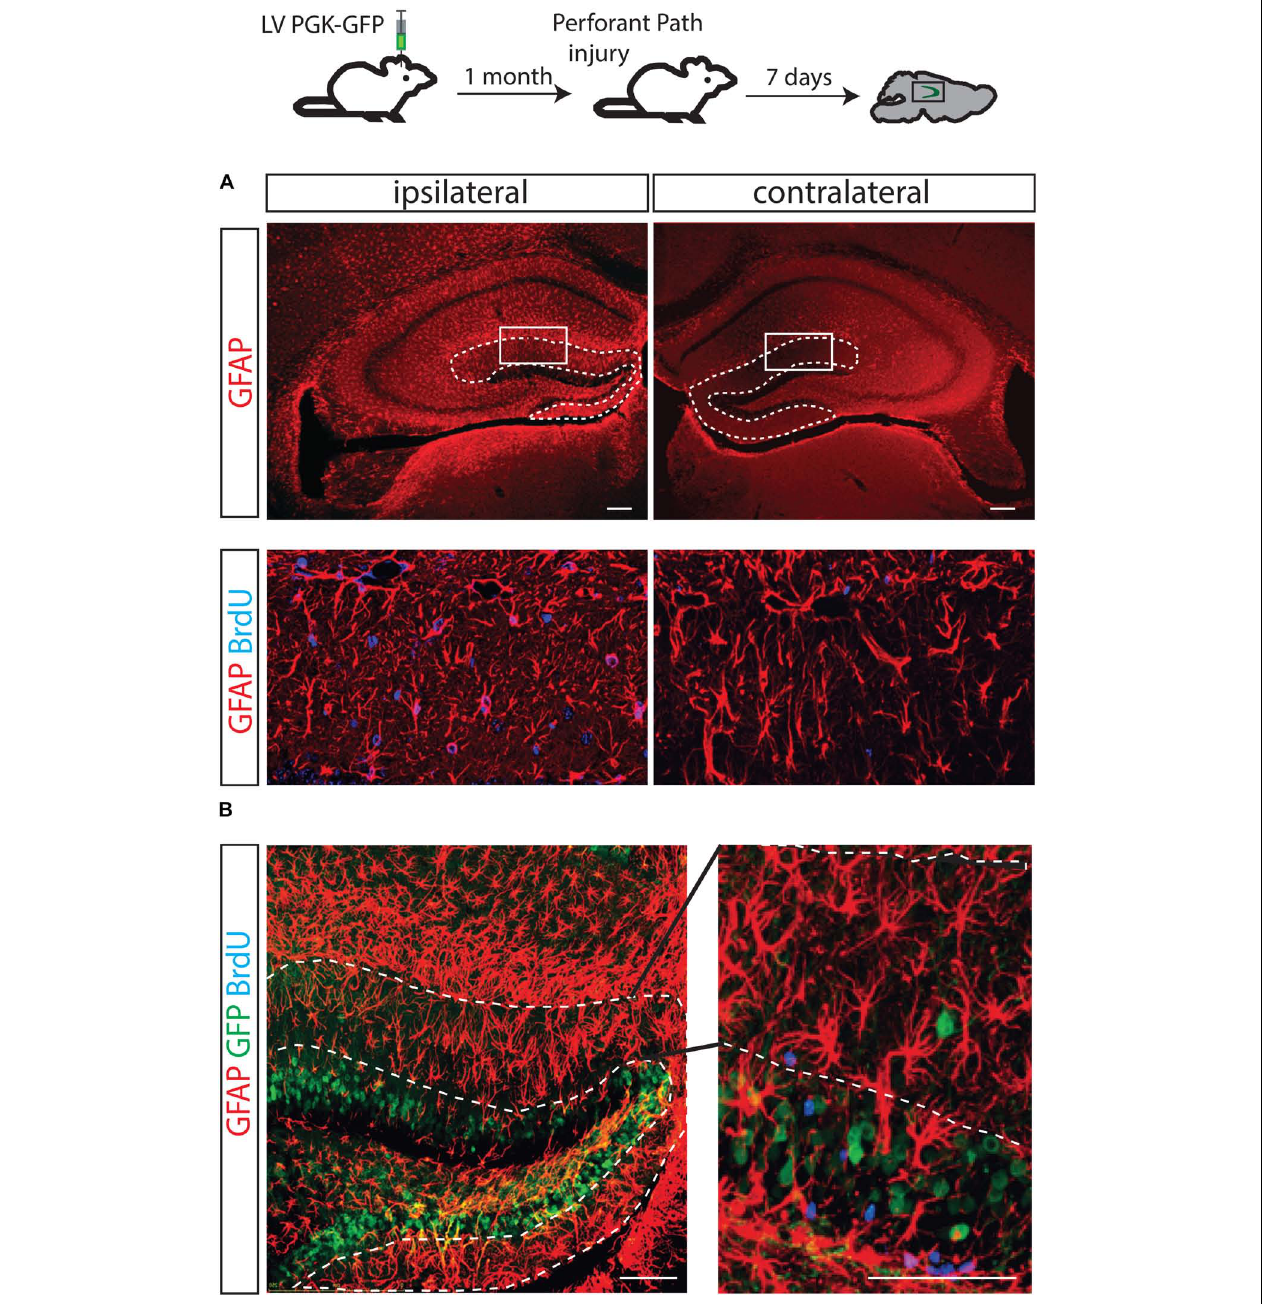
FIGURE 4 | The fate of hippocampal NSCs did not change following PP injury. A brain lesion in the perforant path resulted in over-expression of GFAP-positive cells in the molecular layer of the injury side but not the contralateral side ( A , dotted line). As expected, an increased number of astrocytes (positively stained with BrdU) was found in the molecular layer of the ipsilateral side ( B , left) but not in the contralateral side of these animals ( B , right); however, GFP-labeled progenitors did not contribute to the increased astrocyte